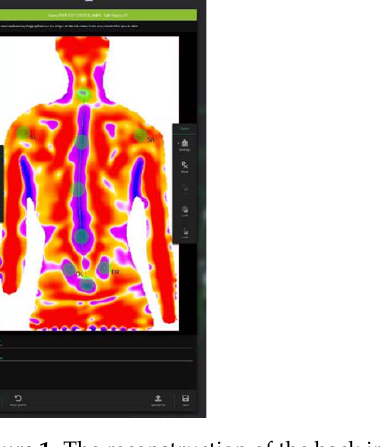
Figure 1. The reconstruction of the back image acquired and showed by the Spine 3D instrument on the panel.